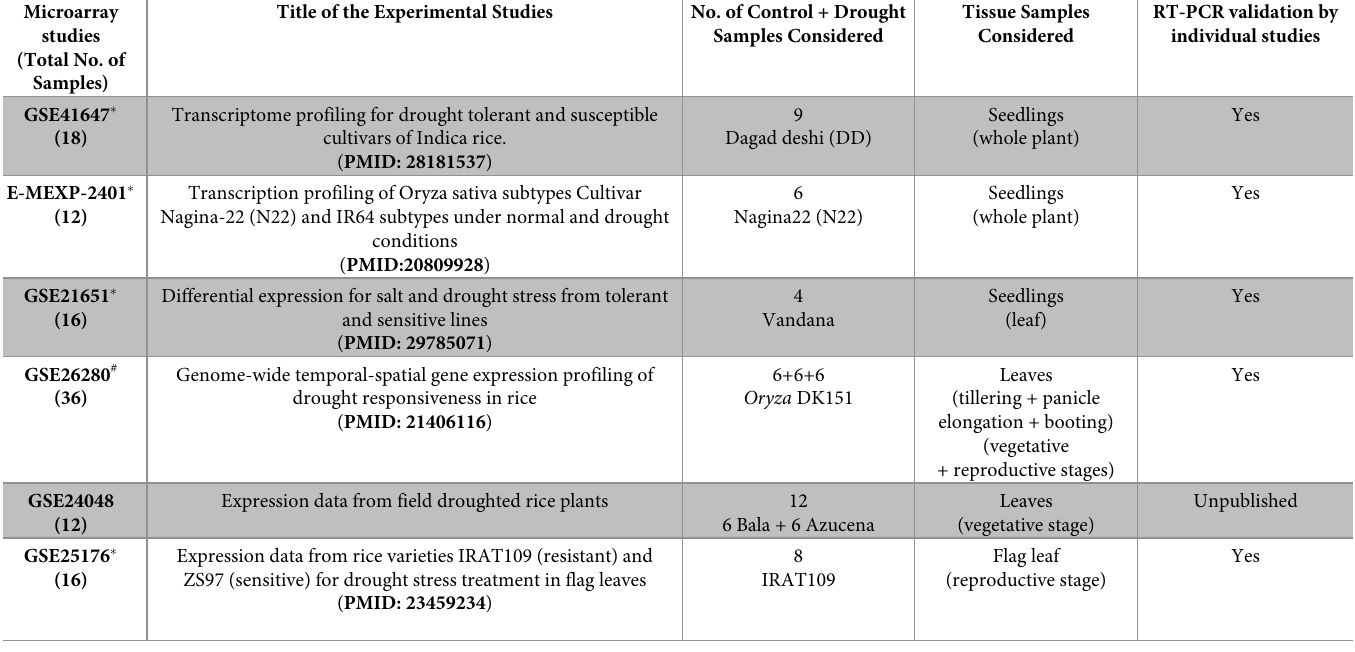
Table 1. Drought-tolerant samples from Affymetrix datasets from NCBI-GEO and ArrayExpress considered for the meta-analytic are listed. Microarray